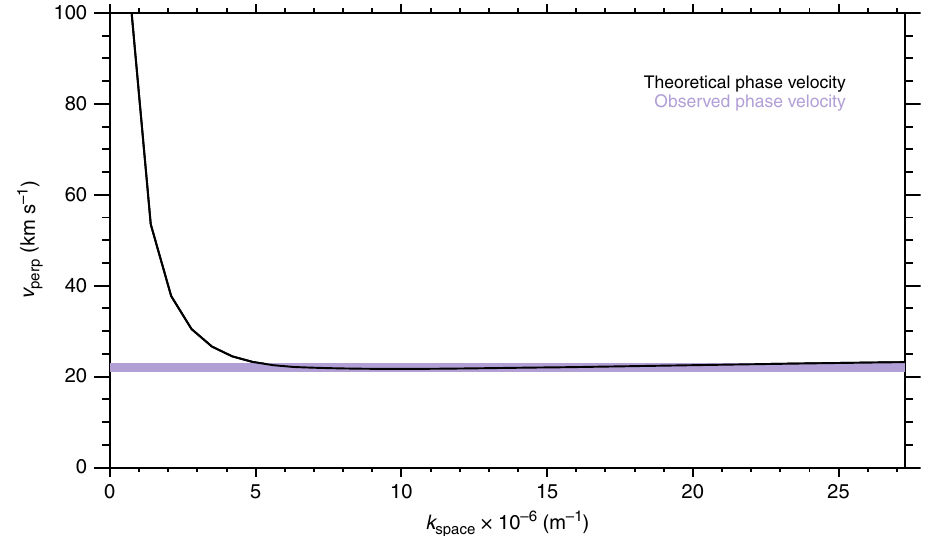
Fig. 3 Comparison of observed and theoretical phase velocities. Perpendicular phase velocity calculated from the theoretical dispersion relation (central dashed line Fig. 2a) indicated in black, with the measured bead perpendicular propagation velocities in the ionosphere which have been mapped to the plasma sheet indicated by the purple shaded